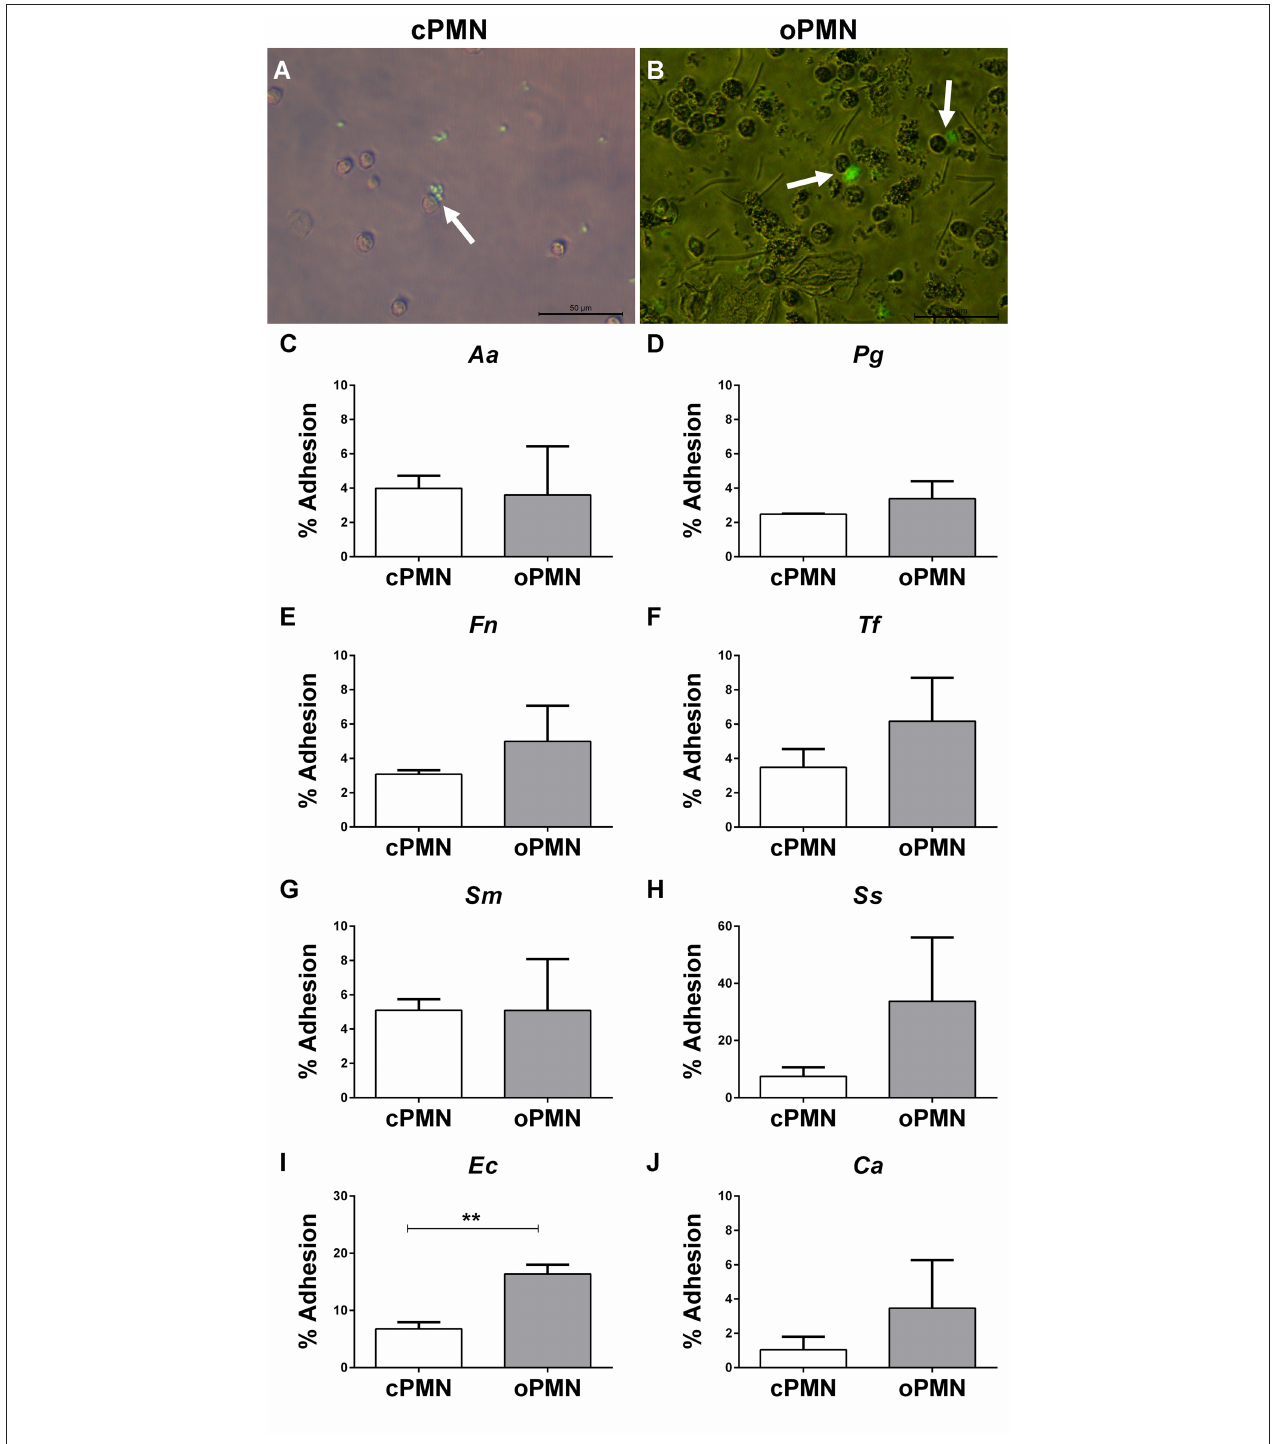
FIGURE 4 | Adhesion by cPMNs and oPMNs. Micrographs of FITC labeled bacterial adhesion by cPMNs (A) and oPMNs (B) . Arrows depict adhesion of FITC labeled bacteria ( Fusobacterium nucleatum) which are shown in green. All micrographs are representatives of 3 independent experiments. Scales represent 50 µ m. Quantitative analysis of adhesion of heat-inactivated A. actinomycetemcomitans [ Aa, (C) ], P. gingivalis [( Pg , (D) ], F. nucleatum [ Fn , (E) ], T. forsythia [ Tf, (F) ], S. mutans [ Sm, (G) ], S. Sanguinis [ Ss , (H) ], E. coli [ Ec, (I) ], and C. albicans [ Ca, (J) ] by cPMNs (white bars) and oPMNs (gray bars). The gating strategy presented in Supplementary Figure 3 was employed for all quantifications. Data are presented as mean ( + SEM) percentages of adhesion, note the variation in y-axis scales. n = 3, ** p < 0.01.